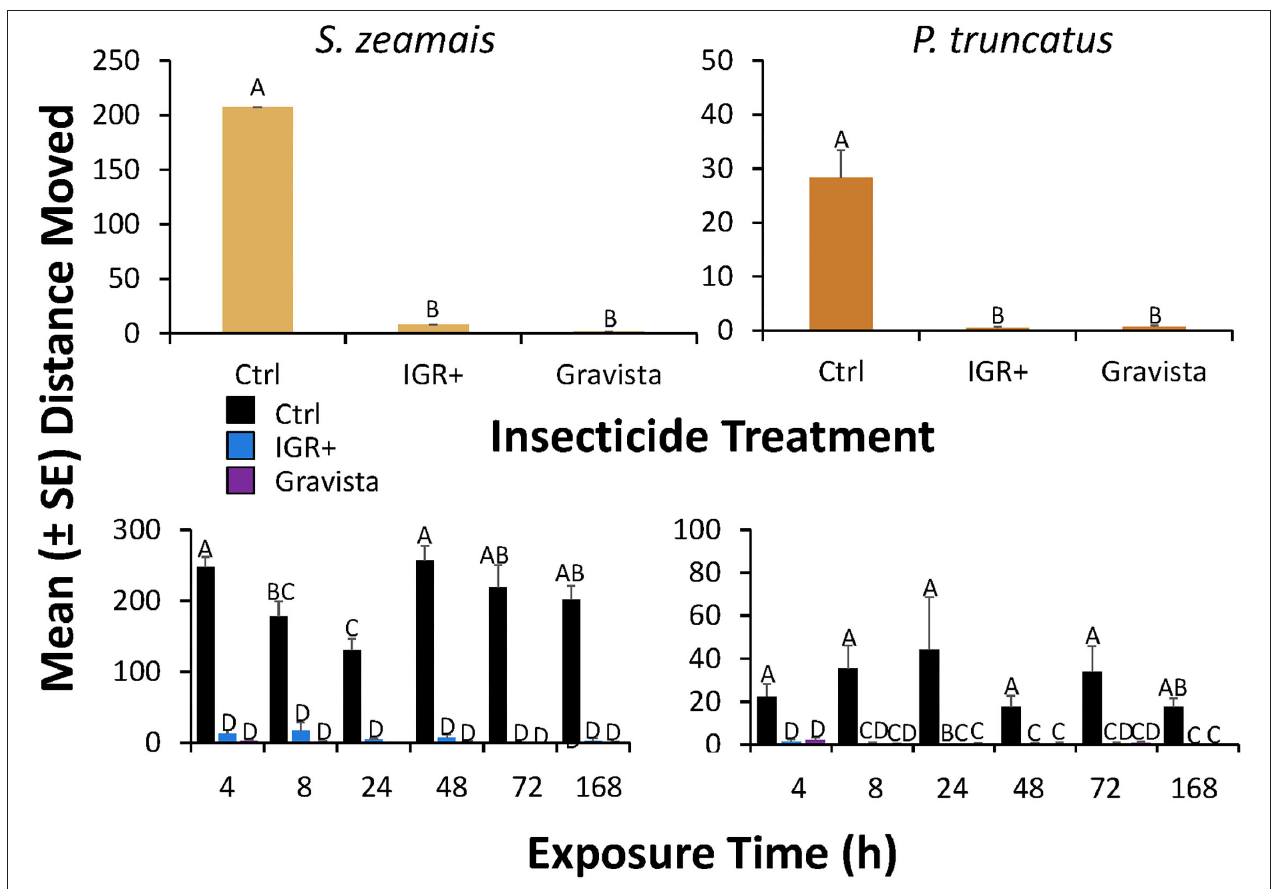
FIGURE 7 | Distance moved ( ± SE) by S. zeamais (left column) and P. truncatus (right column) after application of an existing (methoprene + deltamethrin, IGR + ) and novel (methoprene + deltamethrin + synergist, Gravista) commercial formulation of insecticide to maize as a grain protectant compared to a control overall (top panels) or broken down by exposure time (bottom panels) . Bars with shared letters are not significantly different from each other (Tukey HSD, α =